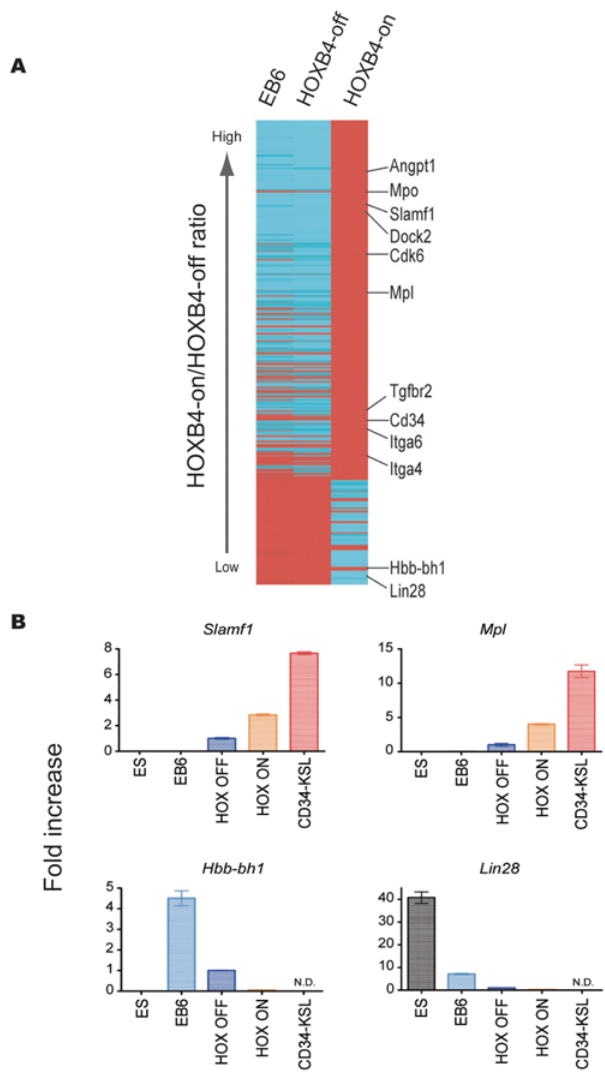
Figure 5. Heat map of differentially expressed genes. (A) Microarray analysis was performed on cDNAs from c-Kit + CD41 + EB6 cells without HOXB4 expression, c-Kit + CD41 + cells after co-culture without HOXB4 expression, and c-Kit + CD41 + cells after co-culture with HOXB4 expression. The finally selected 223 genes are shown in this graph (for selection criteria, see Legend, Table S3). Red indicates genes up- regulated 5-fold or more. Blue indicates genes down-regulated 5-fold or more. (B) Real-time PCR was performed on normalized cDNA from the cells described above, from ESCs maintained without HOXB4 expres- sion, and from CD34 2 KSL cells from adult bone marrow. The mean plus or minus 1SD (n=3) is shown for 4 representative genes.